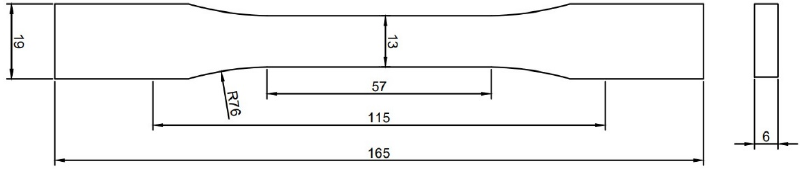
Figure 2. The specifications of the hardness test samples (mm).